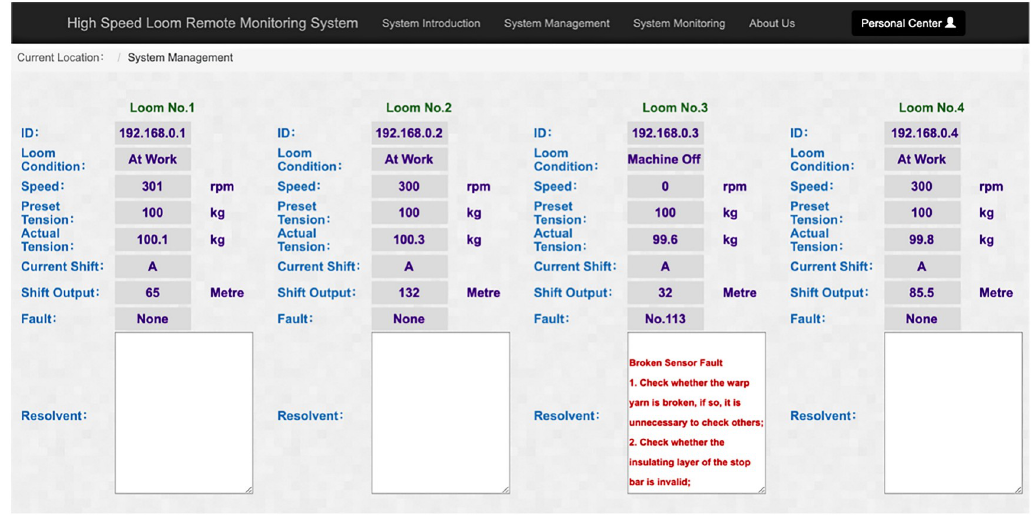
Fig 7. Remote fault diagnosis effect of